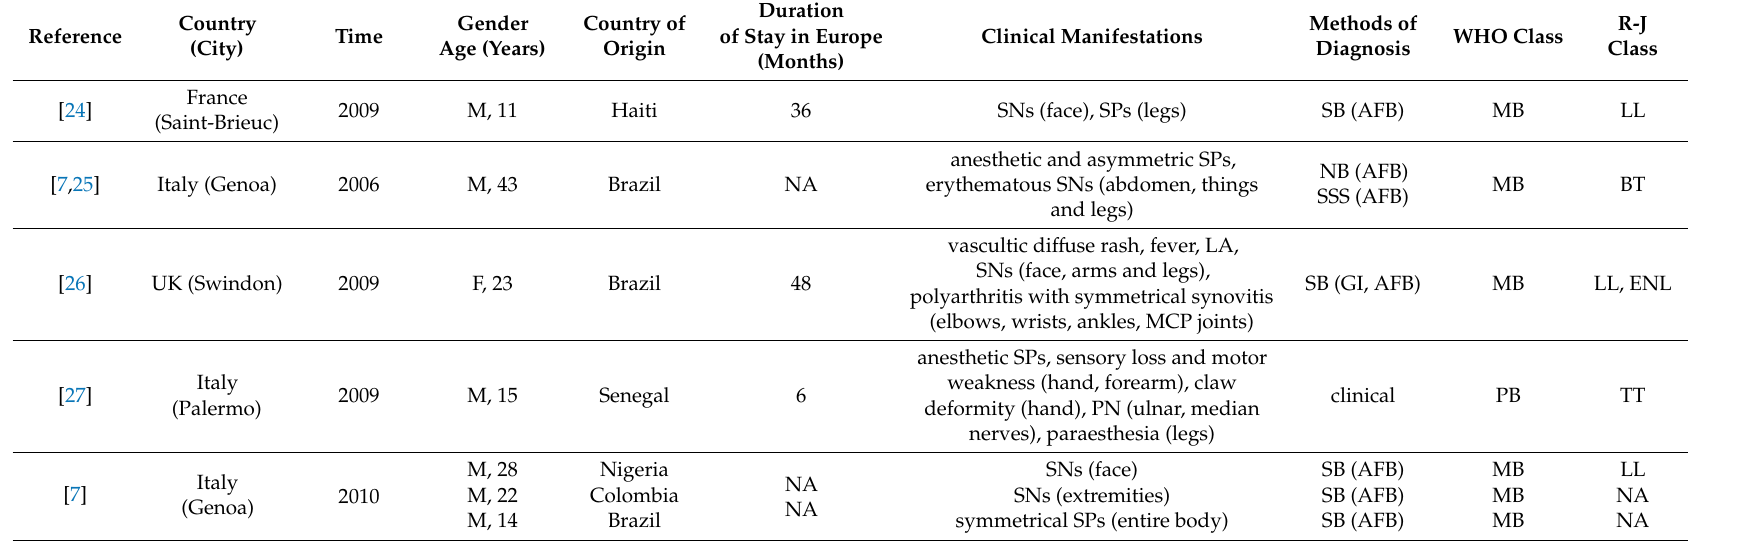
Table 3. Demographic, epidemiologic, and clinical characteristics of 37 migrants diagnosed with leprosy described in 14 case reports and three case series from 2009 to